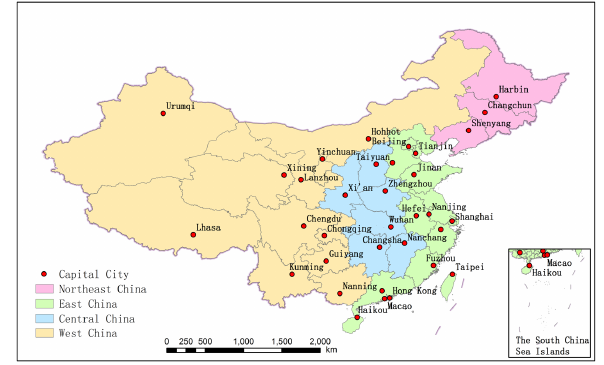
Figure 1. Map of study